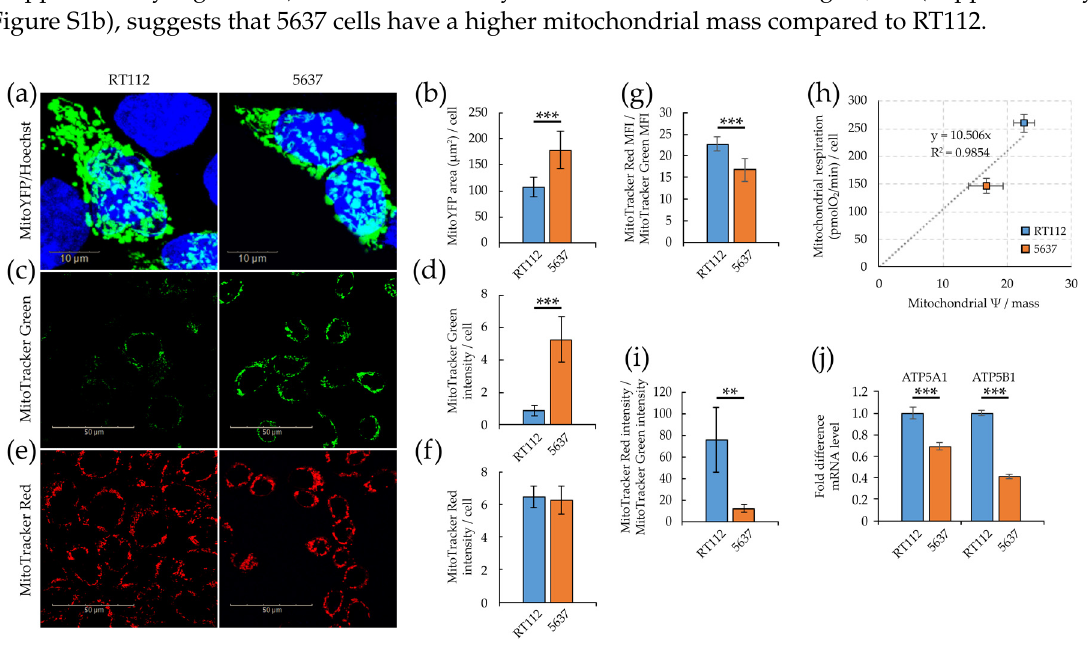
Figure 4. Mitochondrial e ffi ciency of RT112 and 5637 cells. ( a ) Confocal imaging of fixed cells transiently transfected for the expression of the mitochondrial-specific MitoYFP protein (green), stained with Hoechst 33342 dye labeling nuclei (blue). ( b ) Mitochondrial area per cell quantified as the ratio of green (MitoYFP) fluorescent area to blue Hoechst-positive objects (nuclei) in manually selected 30-40 ROIs containing green positive cells. ( c ) Confocal imaging of living cells stained with mitochondrion-selective MitoTracker ™ Green FM (green). ( d ) Mitochondrial mass per cell calculated as the ratio of MitoTracker ™ green fluorescence intensity to blue Hoechst-positive objects (nuclei). ( e ) Confocal imaging of living cells stained with the potentiometric mitochondrion-selective MitoTracker ™ Red CMXRos dye (red). ( f ) Mitochondrial membrane potential per cell calculated as the ratio of MitoTracker ™ Red CMXRos fluorescence intensity to blue Hoechst-positive objects (nuclei). ( g ) Mitochondrial membrane potential per mitochondrial mass unit calculated as the ratio of the median fluorescence intensity of MitoTracker Red CMXRos per cell and the median fluorescence intensity of MitoTracker Green per cell by flow cytometry analysis. ( h ) Correlation between basal respiration OCR and mitochondrial membrane potential per mitochondrial mass unit measured by flow cytometry. ( i ) Mitochondrial membrane potential per mitochondrial mass unit calculated by quantitative imaging as the ratio of the Mitotracker Red and Green’s fluorescence intensity per cell. ( j ) mRNA level by qRT-PCR of ATP5A1 and ATP5B1 genes normalized to the house-keeping HPRT-1 gene level. Quantitative imaging analysis was performed with Harmony software ( b , d , f , i ). All results are the mean of at least three experimental replicates. Statistical test: t -test, ** for p < 0.01; *** for p < 0.001.